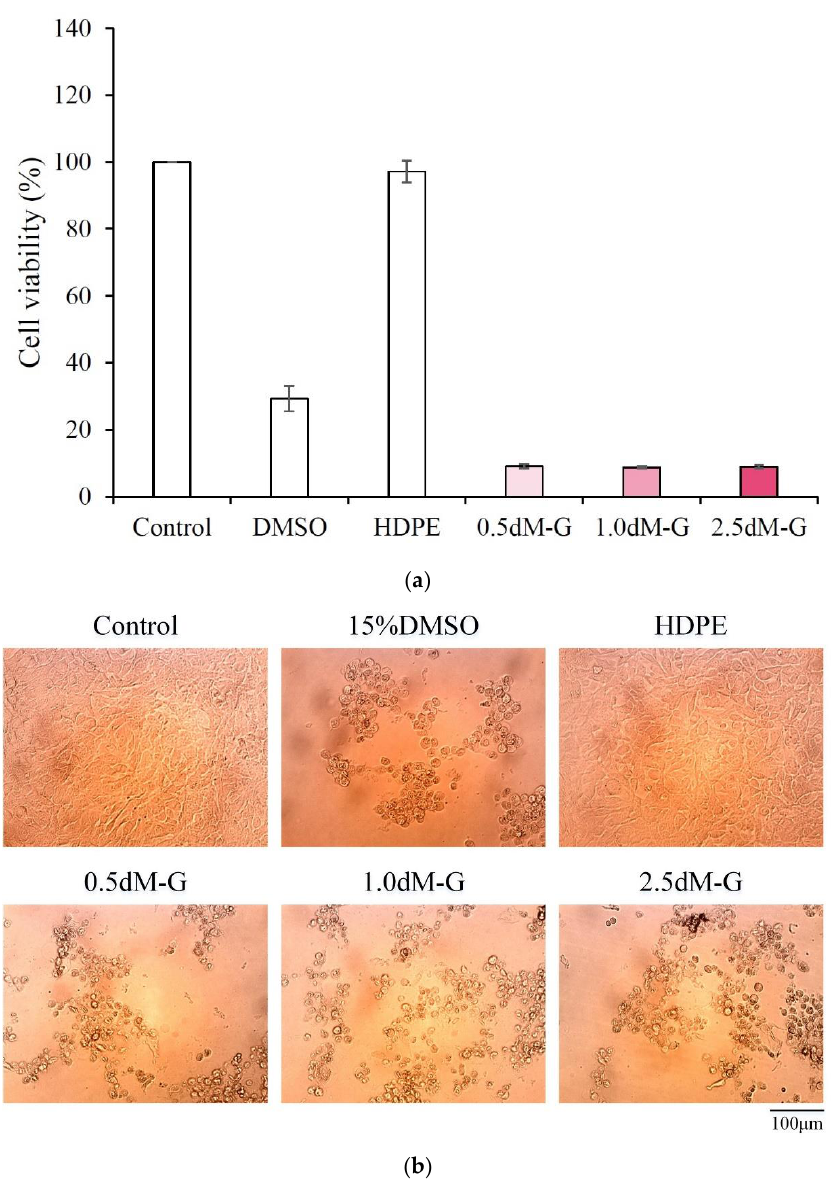
Figure 8. Extract culture with NIH 3T3 cells for 1 day; ( a ) quantitative ( n = 3) and ( b ) qualitative measurements of antibiotic-impregnated microspheres.